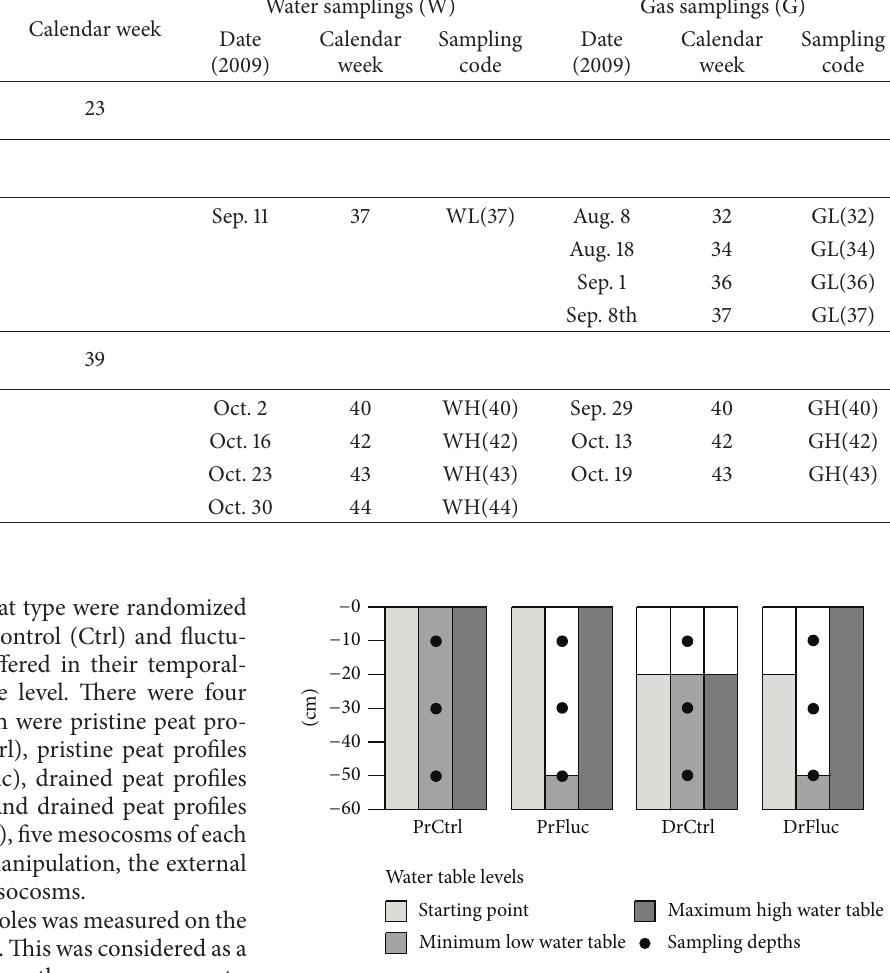
Figure 1: Schematic presentation of the mesocosms. 𝑁 = 5 for each experimental group. Pr: pristine; Dr: drained; Ctrl: control; Fluc: fluctuating water